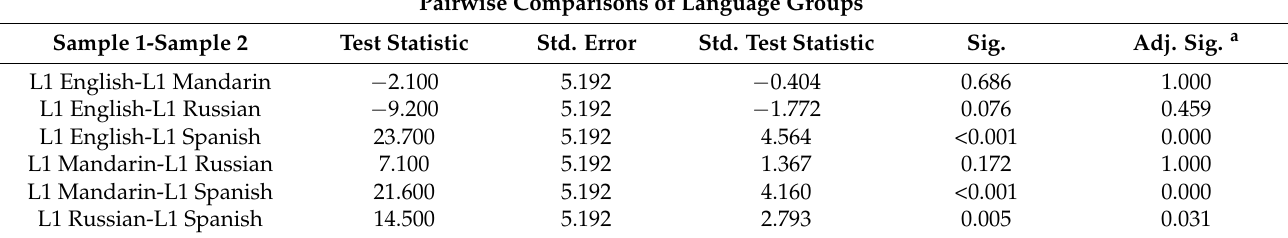
Table 4. Pairwise Comparisons